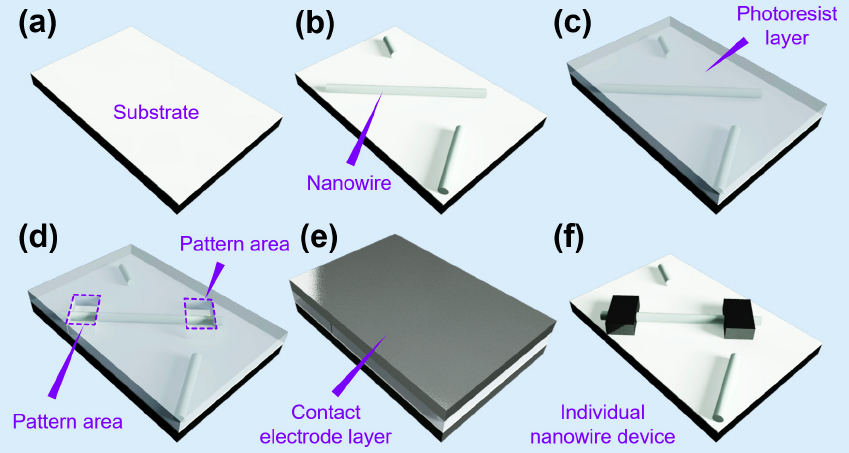
Figure 12. A schematic diagram illustrating the fabrication processes of individual nanowire devices: ( a ) substrate; ( b ) transferring nanowires onto the substrate; ( c ) photoresist coating (sacrificial layer); ( d ) sacrificial layer patterning; ( e ) contact electrode deposition; ( f ) individual nanowire device after lift-off process.